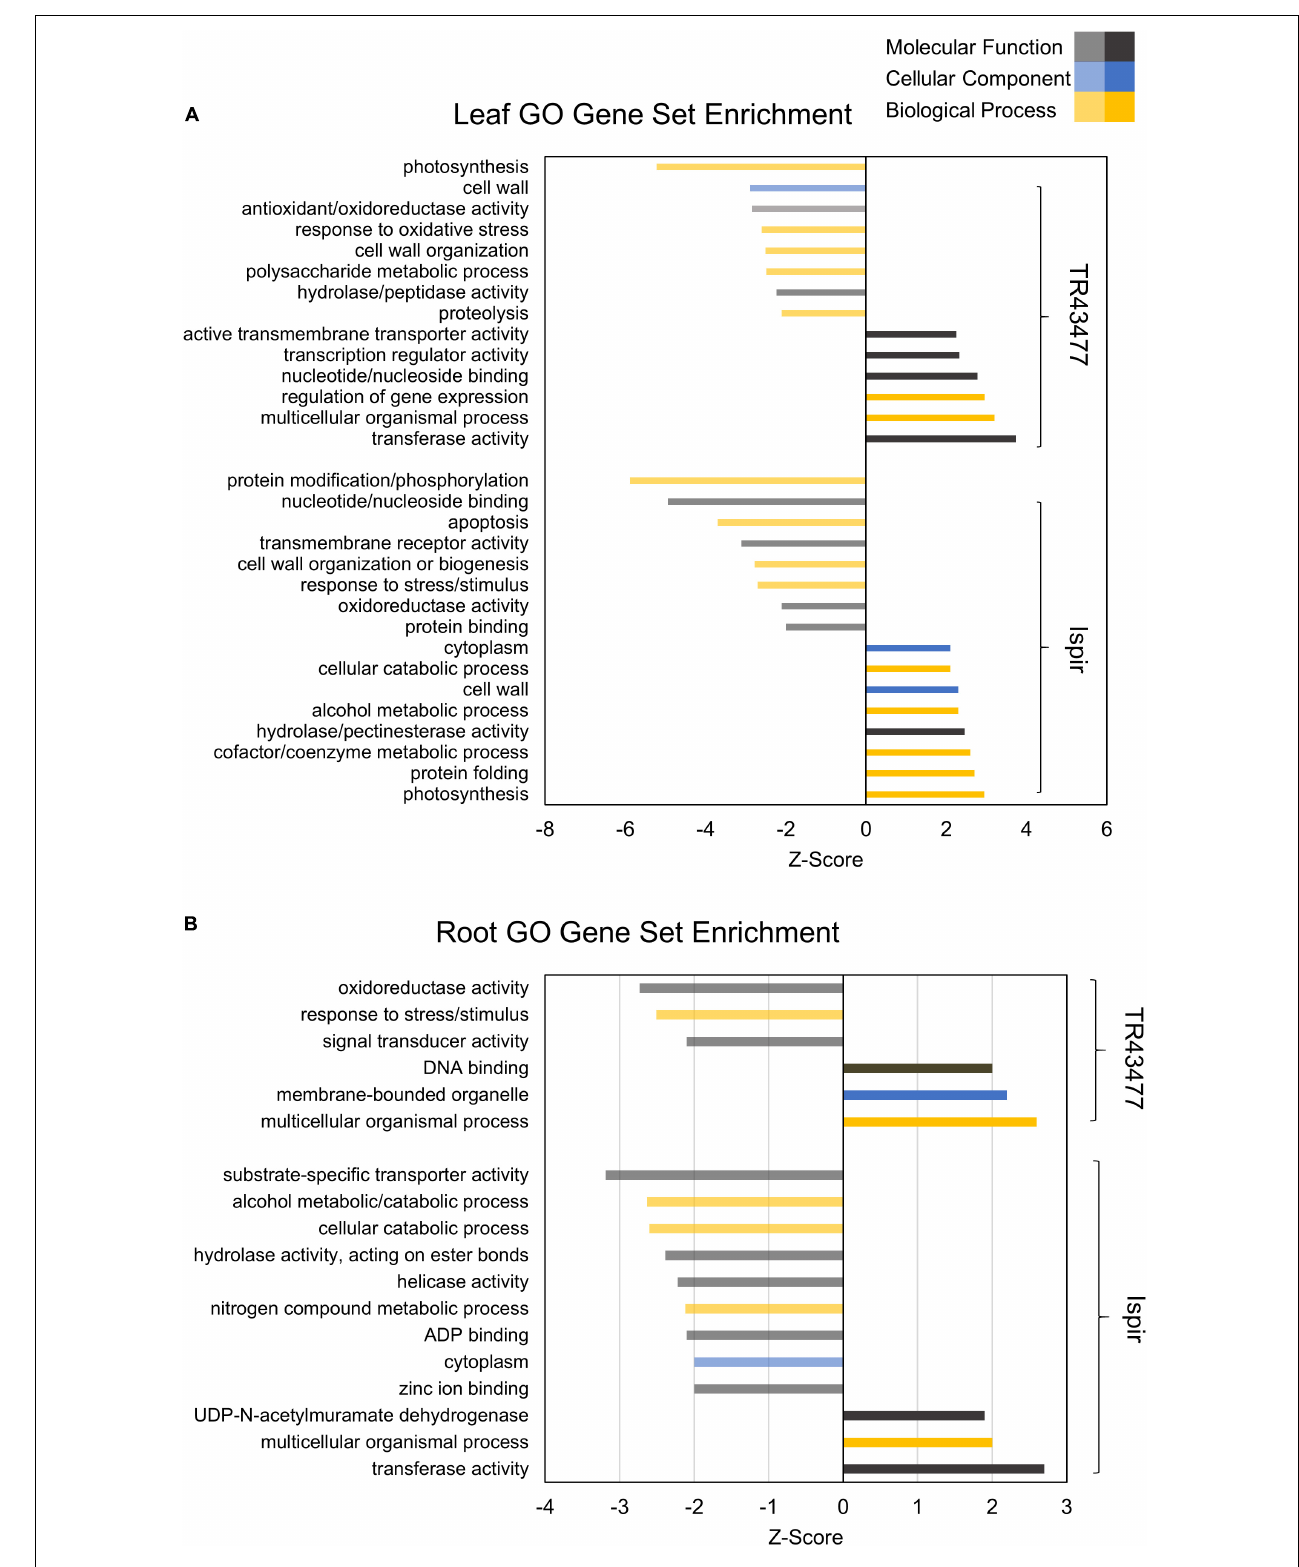
FIGURE 2 | Parametric GO gene set enrichment of leaf (A) and root (B) DEGs. The Z-Score was derived from the number of DEGs and their log 2 FC. Performed for at least five genes in a gene set (adjusted p -value < 0.05).